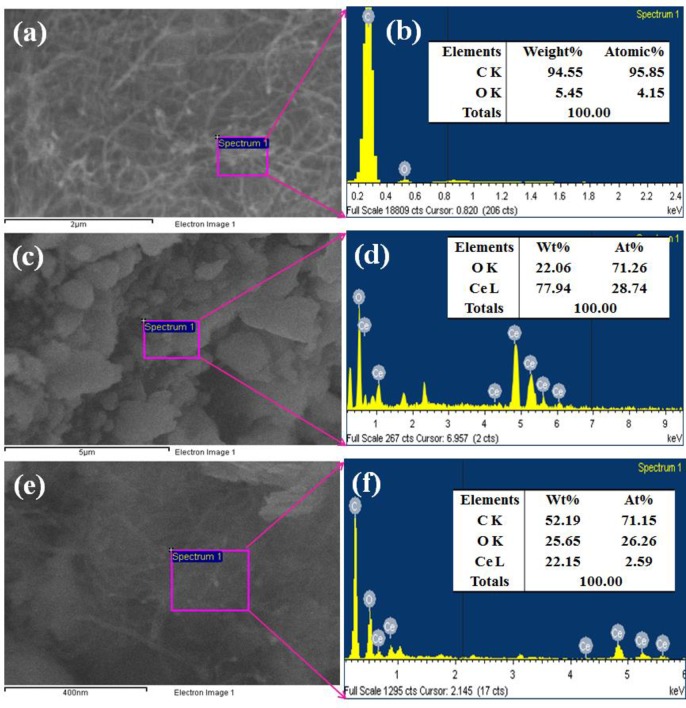
(a-f) Elemental composition of CNT, Ce2O3 NPs and Ce2O3.CNT NCs.